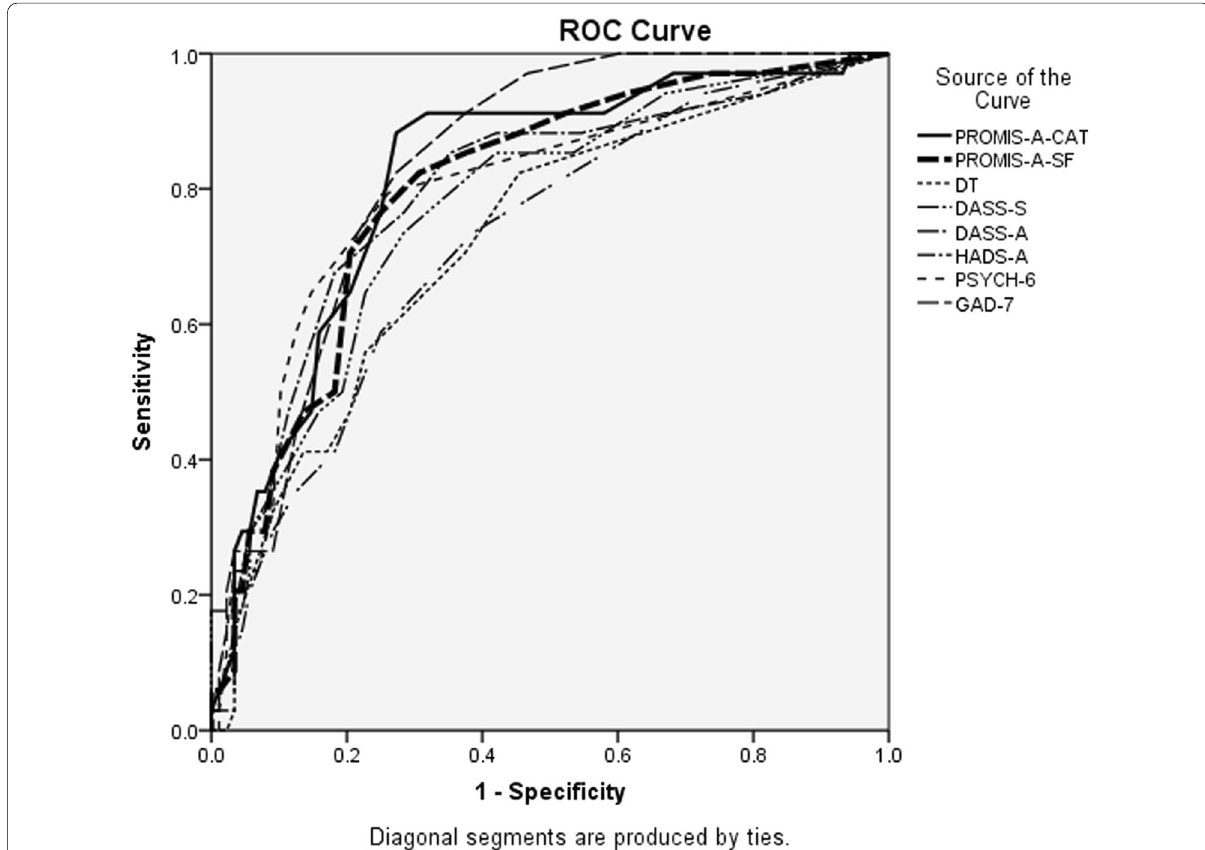
Fig. 1 Area under the curve (ROC) curves of all patient-reported measures versus a SCID diagnosis of Any Anxiety